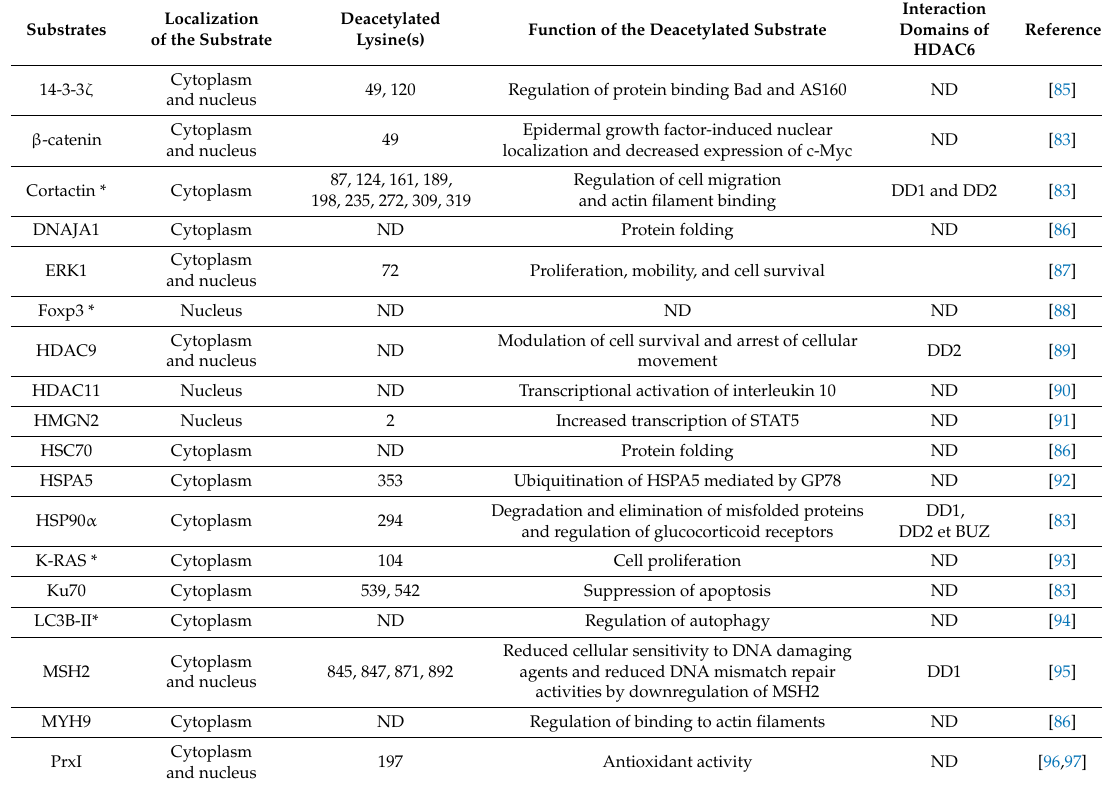
Table 4. List of substrates specifically deacetylated by